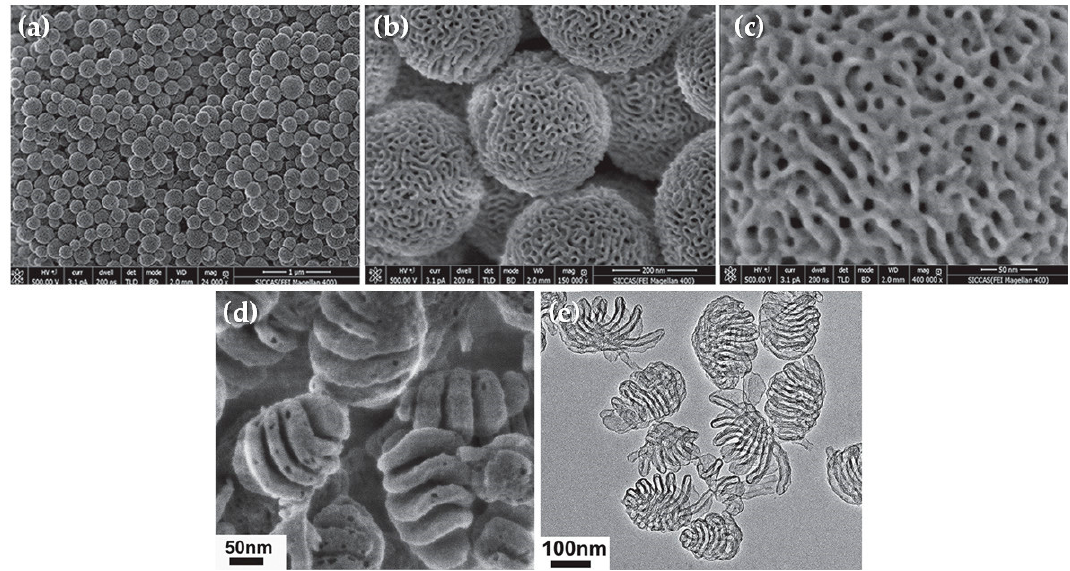
Figure 9. Mesoporous silica nanospheres with tunable pore structure. SEM images of large-pore mesoporous silica nanoparticles in different magnifications: ( a ) 24,000×; ( b ) 150,000× and ( c ) 400, 000×; and flower-like mesoporous nanoparticles obtained with less surfactant: ( d ) SEM image; ( e ) TEM image. Adapted from [55], with permission from John Wiley and